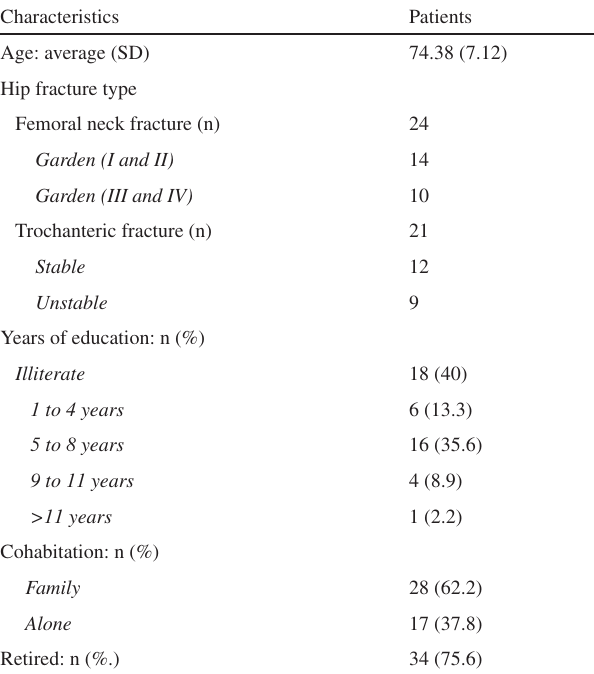
Table 1 - Sample characteristics of 45 patients with hip fractures